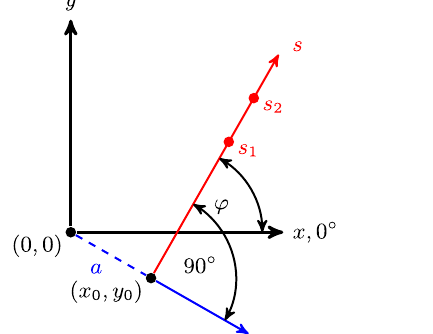
FIG. 2. Mathematicaldescriptionofprobe positioning.The probe orientation is given by s with begin s 1 and end s 2 . The offset of the probe from the machine center is indicated by the dashed line with symbol a [1].